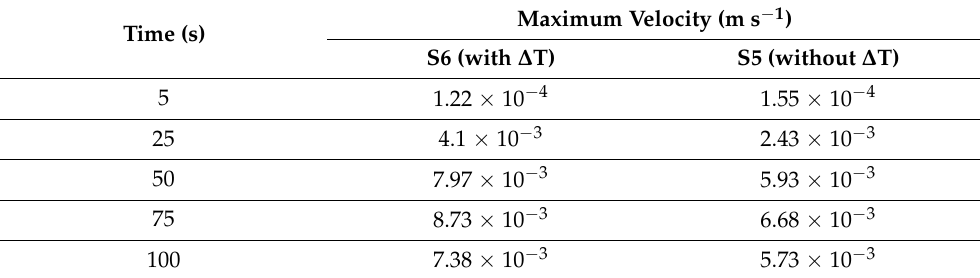
Table 5. Comparison of maximum fluid flow velocities between simulations S6 and S5.